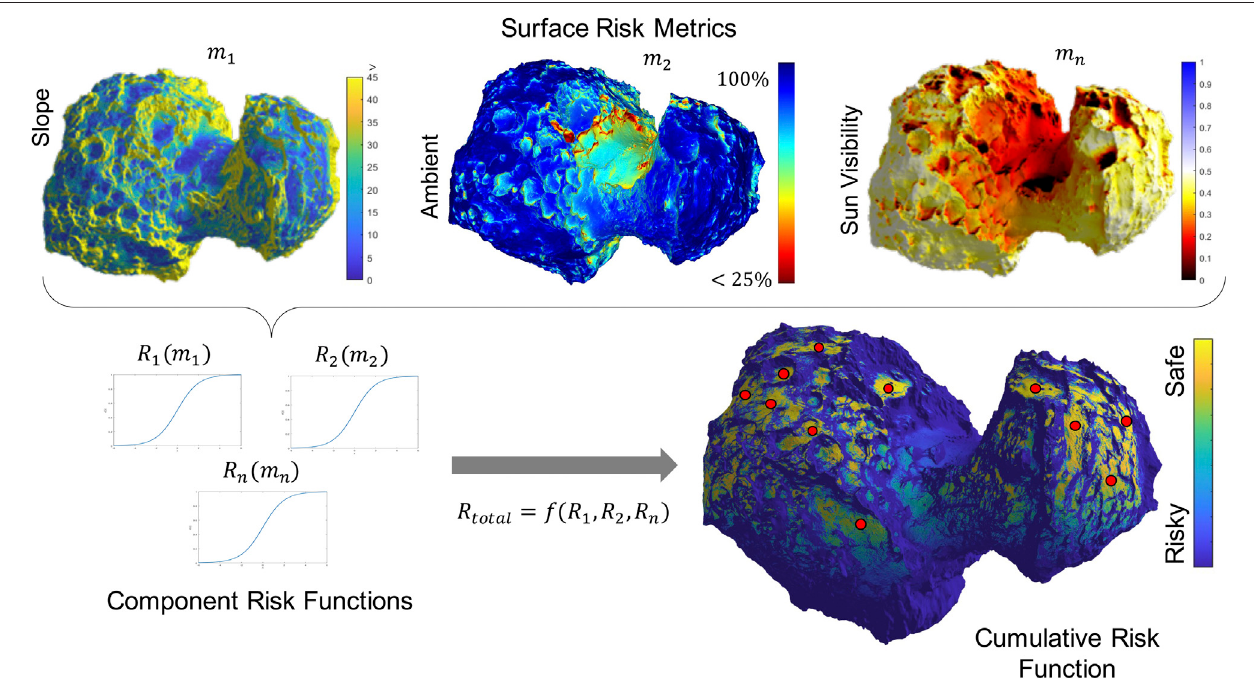
FIGURE6| Illustration ofthelanding-sitehazardassessmentandselectionprocess. (A) Spatiallydistributedriskmetrics computed foracoarseglobalmodel, with local re fi nement in promising regions. (B) Convolution of multiple risk metrics into a cumulative risk metric to identify safe candidate landing sites.